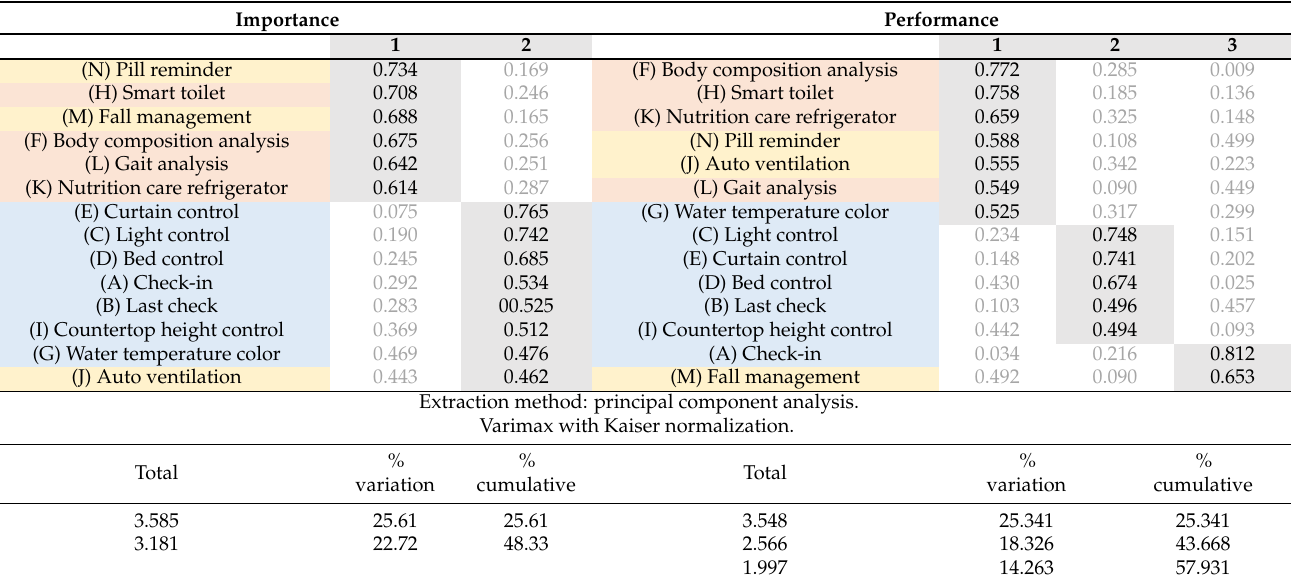
Table 8. Factor analysis (all age